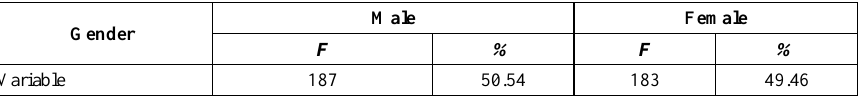
Table 1. Distribution of academicians by